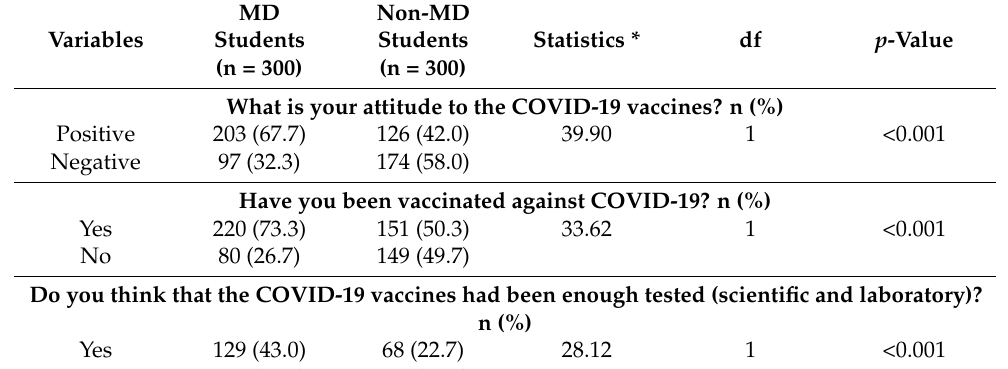
Table 3. Comparison of students’ questionnaire answers for COVID-19 vaccination process and SARS-CoV-2 vaccines.